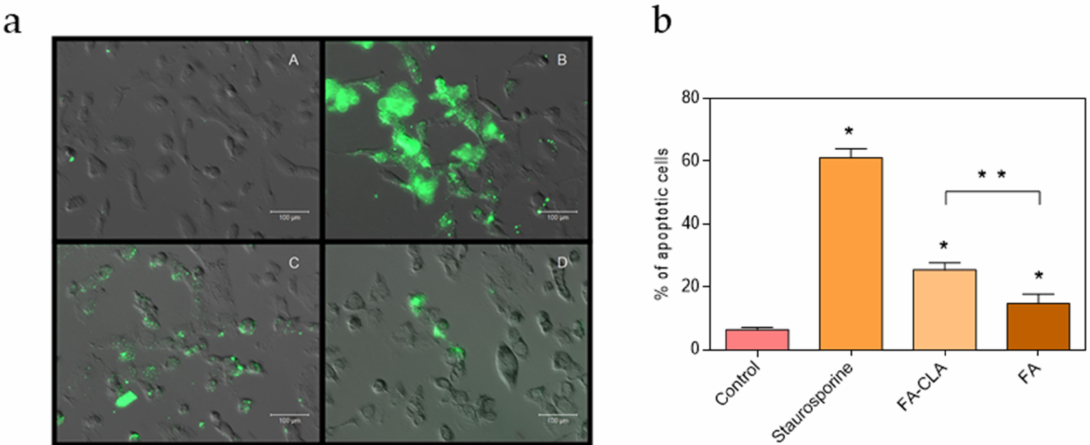
Figure 3. Detection of apoptotic cells with the Annexin-V-FLUOS Staining Kit Culture conditions of WM793 cells: A— control sample, B—staurosporine at a concentration of 1.5 µ M, C—fatty acid mixture extracted from CLA-enriched chicken egg yolk, D—fatty acid mixture extracted from non-CLA-enriched chicken egg yolk. Apoptotic cells—green colour ( a ). Effect of a mixture of fatty acids extracted from egg yolk enriched and not enriched in CLA on apoptosis of human cancer cells line WM793. The graph indicates the percentage of apoptotic cells relative to all the cells cultured under each condition. The statistical significance of the differences, with respect to the control sample, was assessed by the Mann–Whitney U test with a significance level of p ≤ 0.05 (*) and p ≤ 0.01 (**) ( b ) The results are presented as mean, ± SD for n =